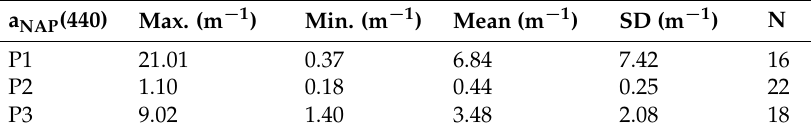
Figure 9. Hourly non-algal particles absorption coefficients at 440 nm at Stations P1 (red squares, N = 16), P2 (green circles, N = 22) and P3 (blue triangles, N=18). The diurnal variation of a NAP (440) showed significant difference for Stations P1, P2 and P3. Table 4. Statistics of non-algal particles absorption coefficients at 440 nm at different stations. “Max.”, “Min.”, and “SD” stand for maximum, minimum, and standard deviation, respectively, and “N” is the number of